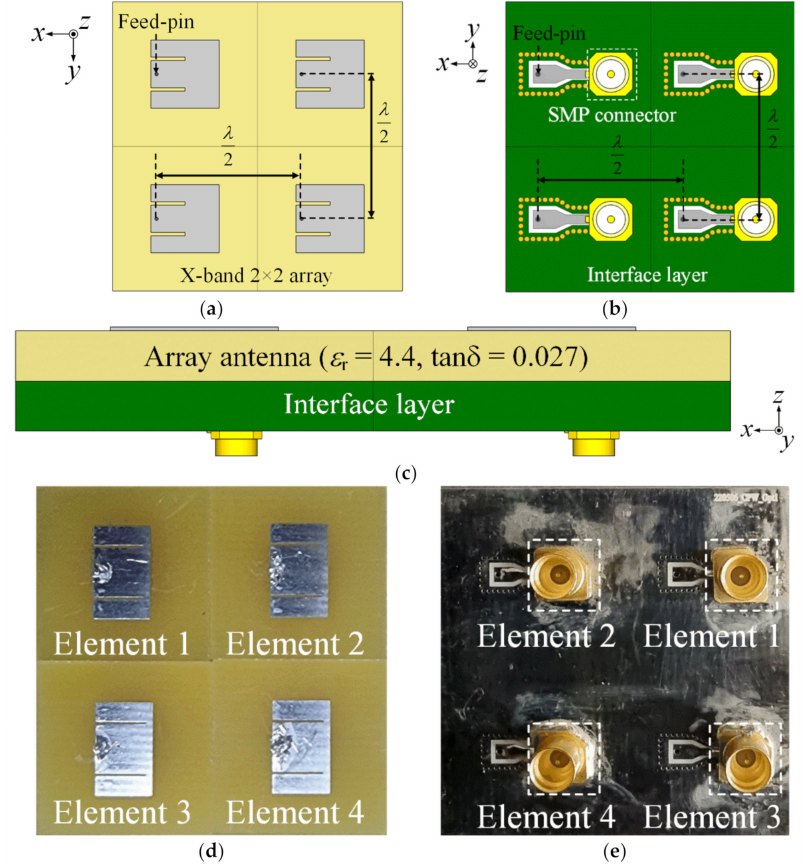
Figure 7. Geometry and fabrication of the 2 × 2 E-shape array antennas with the proposed interface layer: ( a ) isometric view; ( b ) top view; ( c ) side view; ( d ) top view photograph; ( e ) bottom view